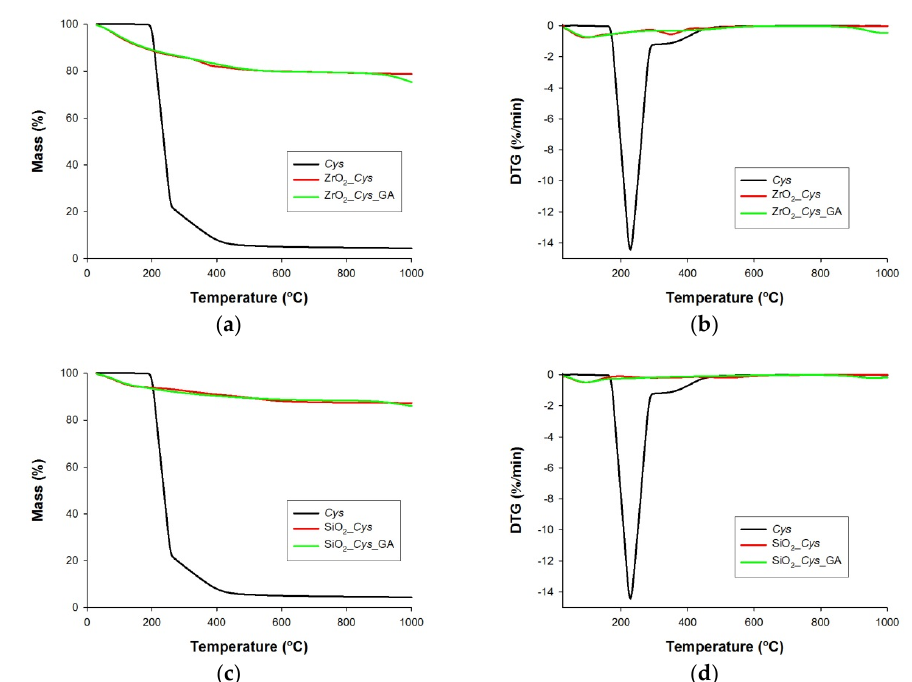
Figure 1. Thermogravimetric curves and their first derivatives (DTG). ( a , c ) ZrO 2 _ Cys and ZrO 2 _ Cys _GA; ( b , d ) SiO 2 _ Cys and SiO 2 _ Cys _GA.